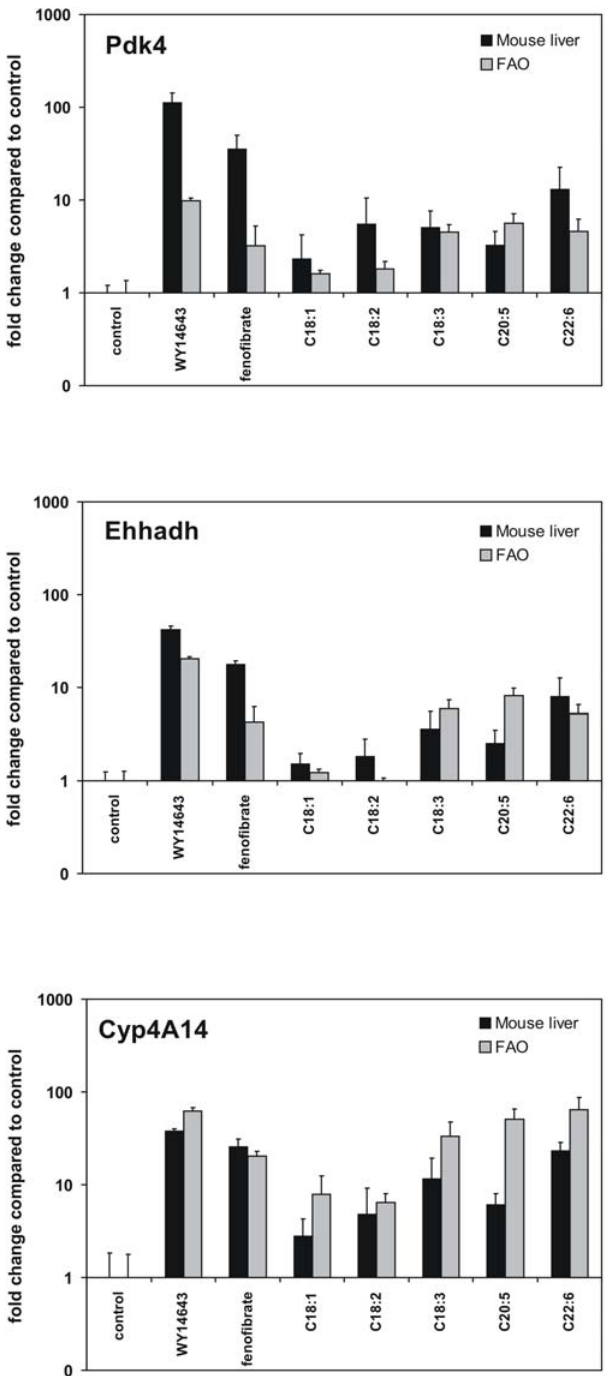
Figure 5. Close agreement between fatty acid-dependent gene regulation invivo and invitro . mRNA expression of three genes ( Pdk4 , Ehhadh and Cyp4A14 ) was determined in mouse liver and in rat hepatoma FAO cells using quantitative real-time PCR. Results are shown as fold-change compared to control group. Error bars represent SD.